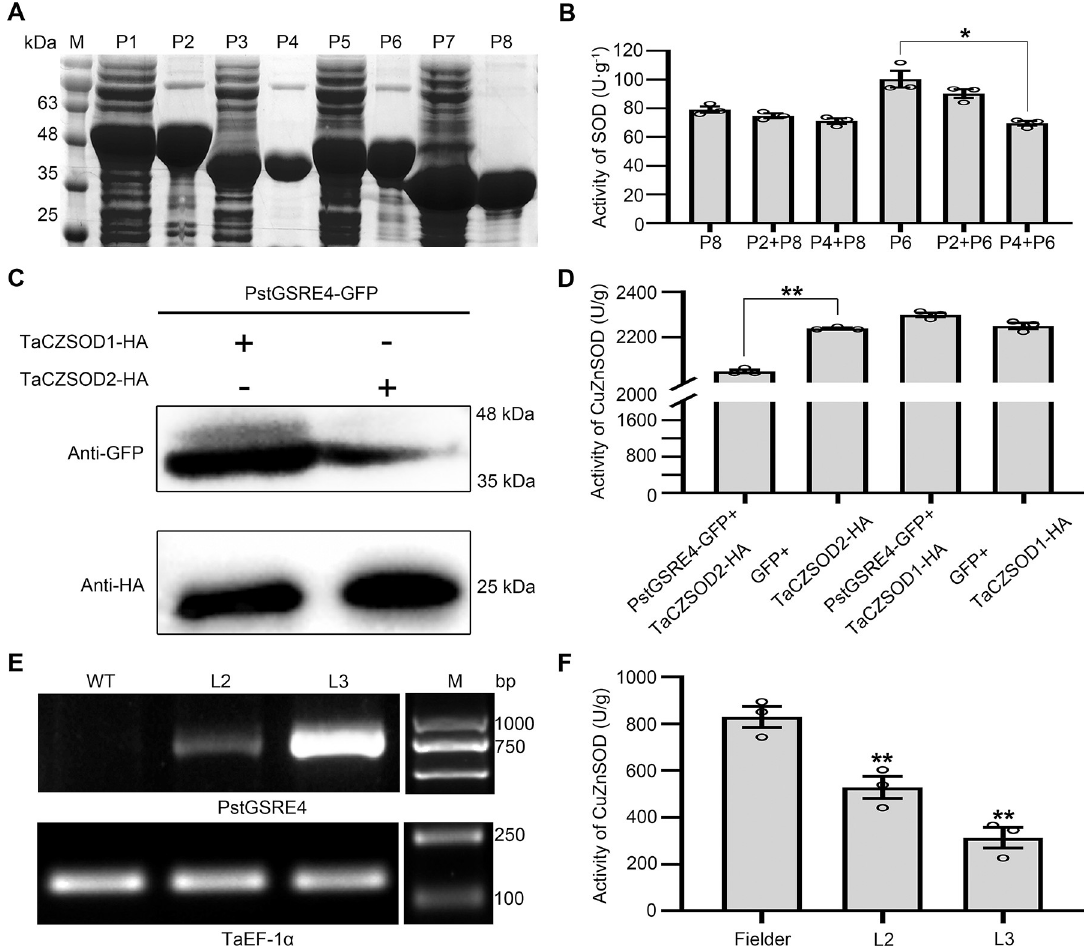
Fig 6. PstGSRE4 inhibits the activity of TaCZSOD2 in vitro and in vivo . (A) SDS-PAGE analysis of recombinant proteins purified from E . coli . The protein bands were visualized by Coomassie staining. M, Marker. P1, recombinant protein eGFP-His with induction by isopropyl- β -D-thiogalactopyranoside (IPTG). P2, purified recombinant protein eGFP-His. P3, recombinant protein PstGSRE4-His with induction by IPTG. P4, purified recombinant protein PstGSRE4-His. P5, recombinant protein TaCZSOD2-His with induction by IPTG. P6, purified recombinant protein TaCZSOD2-His. P7, recombinant protein TaCZSOD1-His with induction by IPTG. P8, purified recombinant protein TaCZSOD1-His. (B) Nitro-blue tetrazolium (NBT) photoreduction method was used to detect the activity of SOD. The TaCZSOD1-His was used as negative control. (C-D) Using the co-expression method to detect the activity of CuZnSOD in tobacco. Western blot was performed to show normal expression of PstGSRE4-GFP with anti-GFP antibody, TaCZSOD1-HA and TaCZSOD2-HA with anti-HA antibody. Co-express PstGSRE4-GFP and TaCZSOD1-HA/TaCZSOD2-HA respectively in tobacco, then detect the activity of CuZnSOD by using the CuZnSOD assay kit after 48 hpt (hours post treatment). (E-F) Using PstGSRE4 - overexpression lines to detect the activity of CuZnSOD in wheat. The activity of CuZnSOD in different transgene lines were detected by using the CuZnSOD assay kit at 48 hpi with Pst . RT-PCR was used to detect the expression of PstGSRE4 . Expression of TaEF-1 α showed equal loading. WT, wild type, cv. Fielder. L2-L3, the third generation of PstGSRE4 -overexpression wheat lines. Values represent the means ± SE of three independent samples. Asterisks indicate P < 0.05, double asterisks indicate P < 0.01.